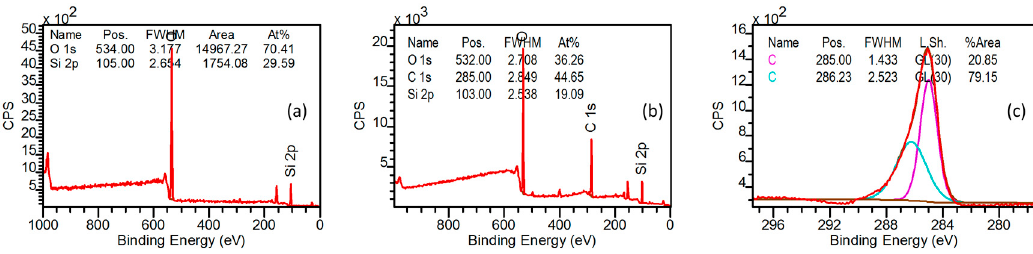
Figure 2. XPS wide scan spectra of unmodified SMP ( a ) and after hybridization with Poly-SMP- Py β CD ( 4 , b ) and narrow-scan of the C1s region after hybridization with Poly-SMP-Py β CD ( 4 , c ).